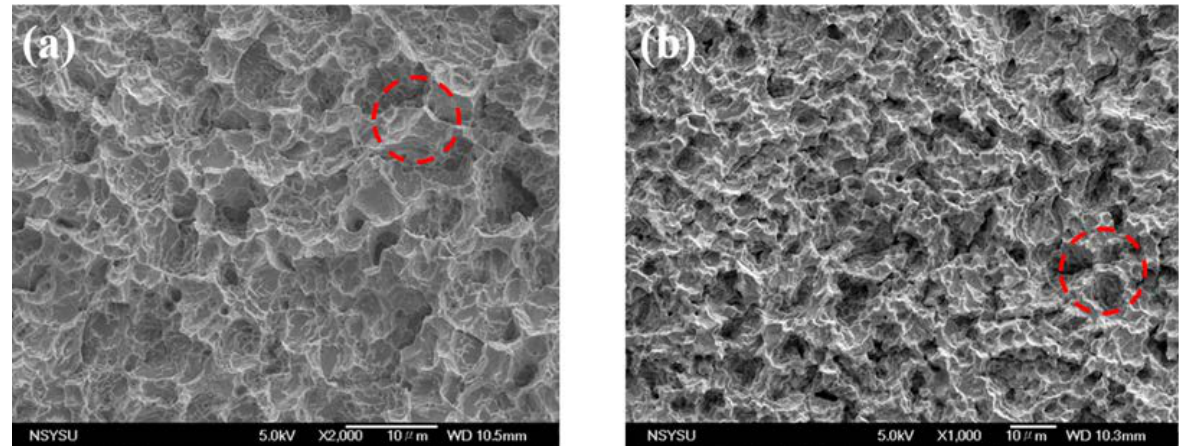
Figure 5. SEM images of control groups ( a ) SLA Ti, and ( b ) Oxide Ti.